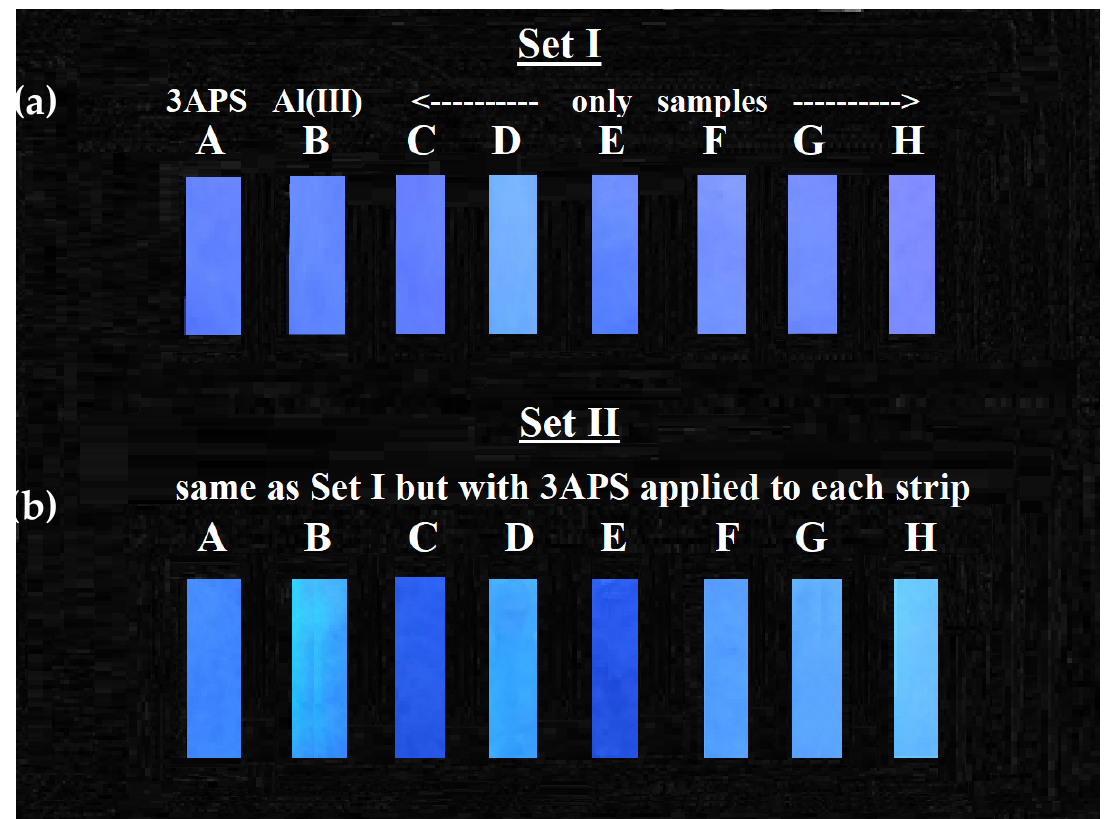
Figure 13. Set I: A: 3APS alone; B: Al(III) alone; C – H: commercial samples only (C and E are Al-free) ( a ). Set II: A: 3APS alone; B: Al(III) + 3APS; C – H: commercial samples + 3APS ( b ).